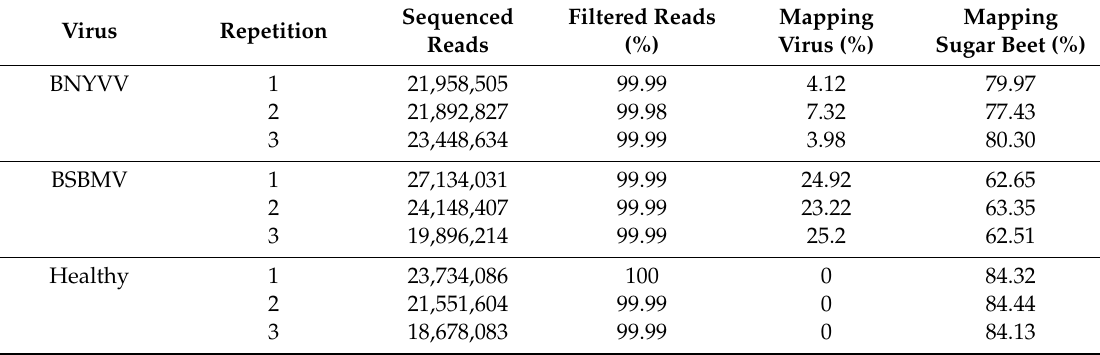
Table 1. Summary of raw Illumina sequencing and filtered reads after trimming and alignment of reads to virus and sugar beet